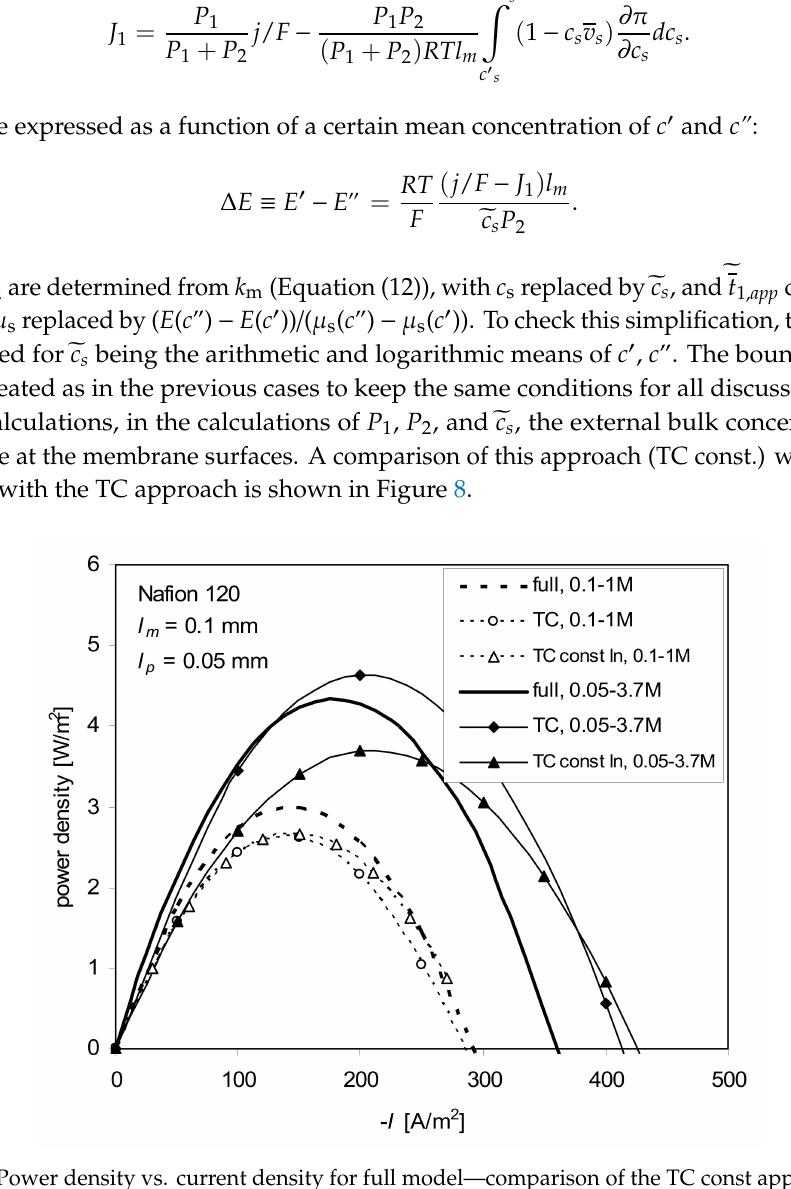
Figure 8. Power density vs. current density for full model—comparison of the TC const approach with logarithmic mean with the TC approach and the full ITE for the concentrations 0.1–1 M and 0.05–3.7 M NaCl; l m = 0.1 mm, l p = 0.05 mm, T = 298